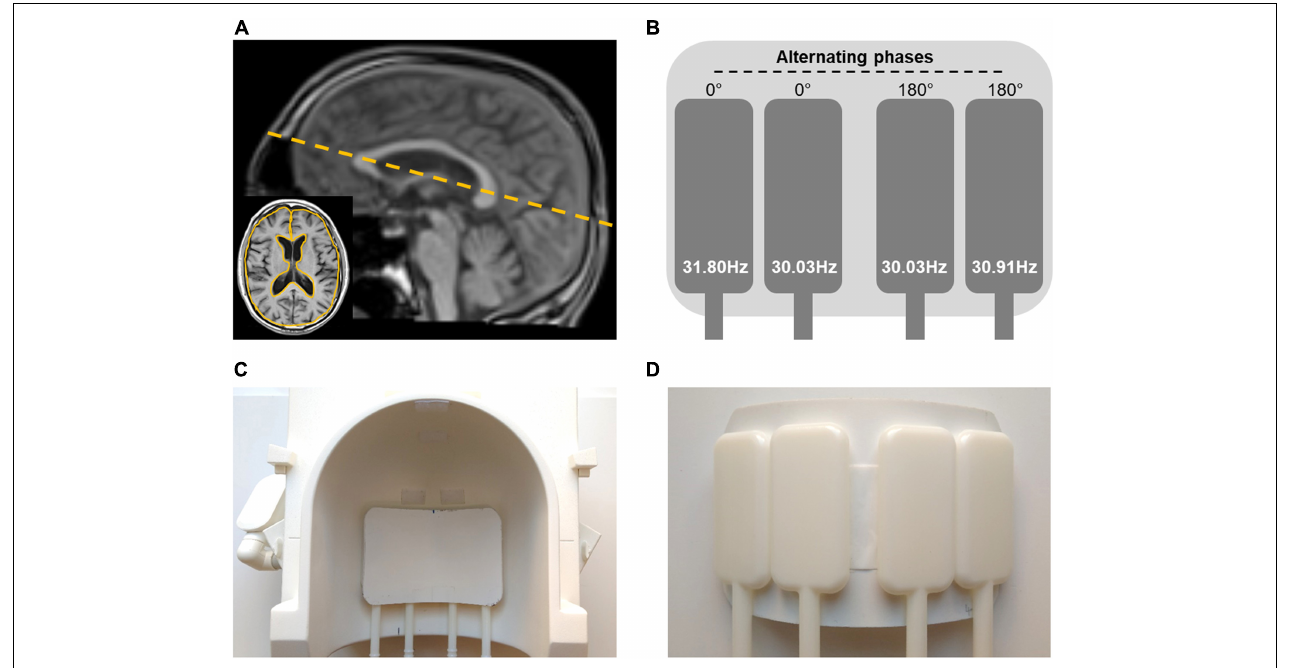
FIGURE 1 | Experimental setup. (A) Image slice position (dashed yellow line) and region of interest (ROI) based on anatomical image (yellow solid line in the insert) for rt-MMRE of the brain. (B) Diagram of the four flask drivers with vibration frequencies and 180 ◦ -phase alterations between the drivers. (C) Top view of positioning of actuator setup in the 32-channel head coil. (D) Bottom view of driver